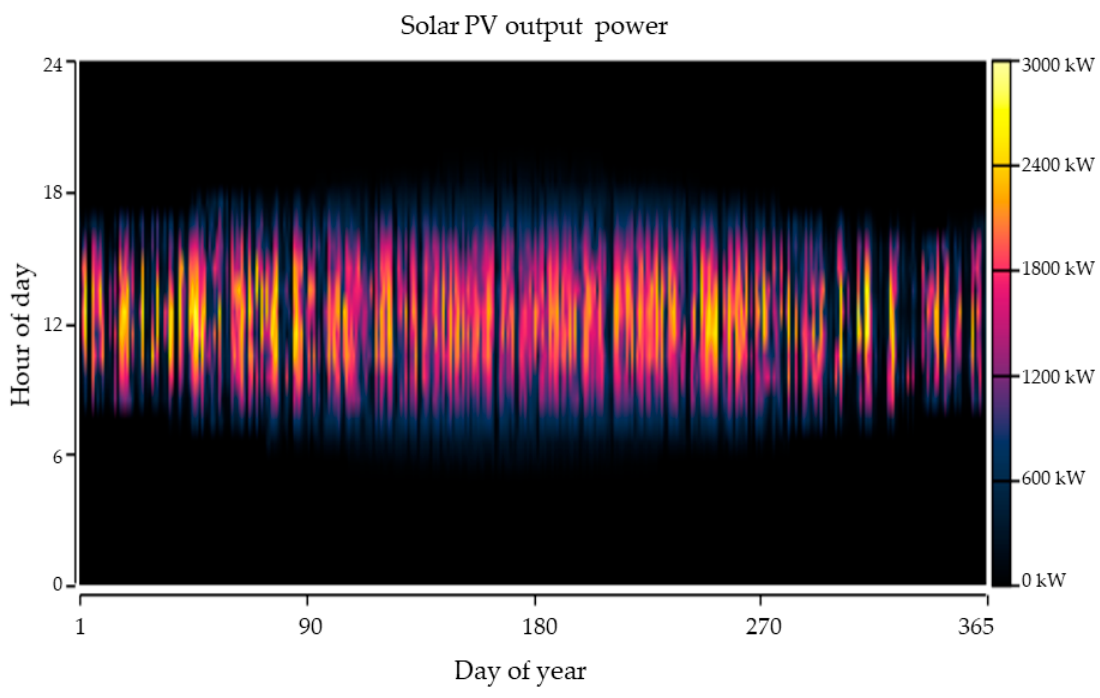
Figure 9. Annual electricity production by the solar PV system.